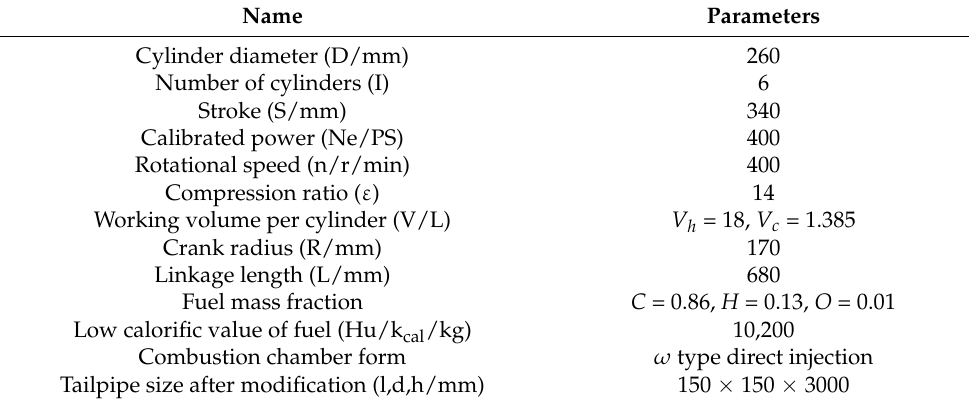
Table 3. Parameters of 6260ZCD-type marine supercharged diesel